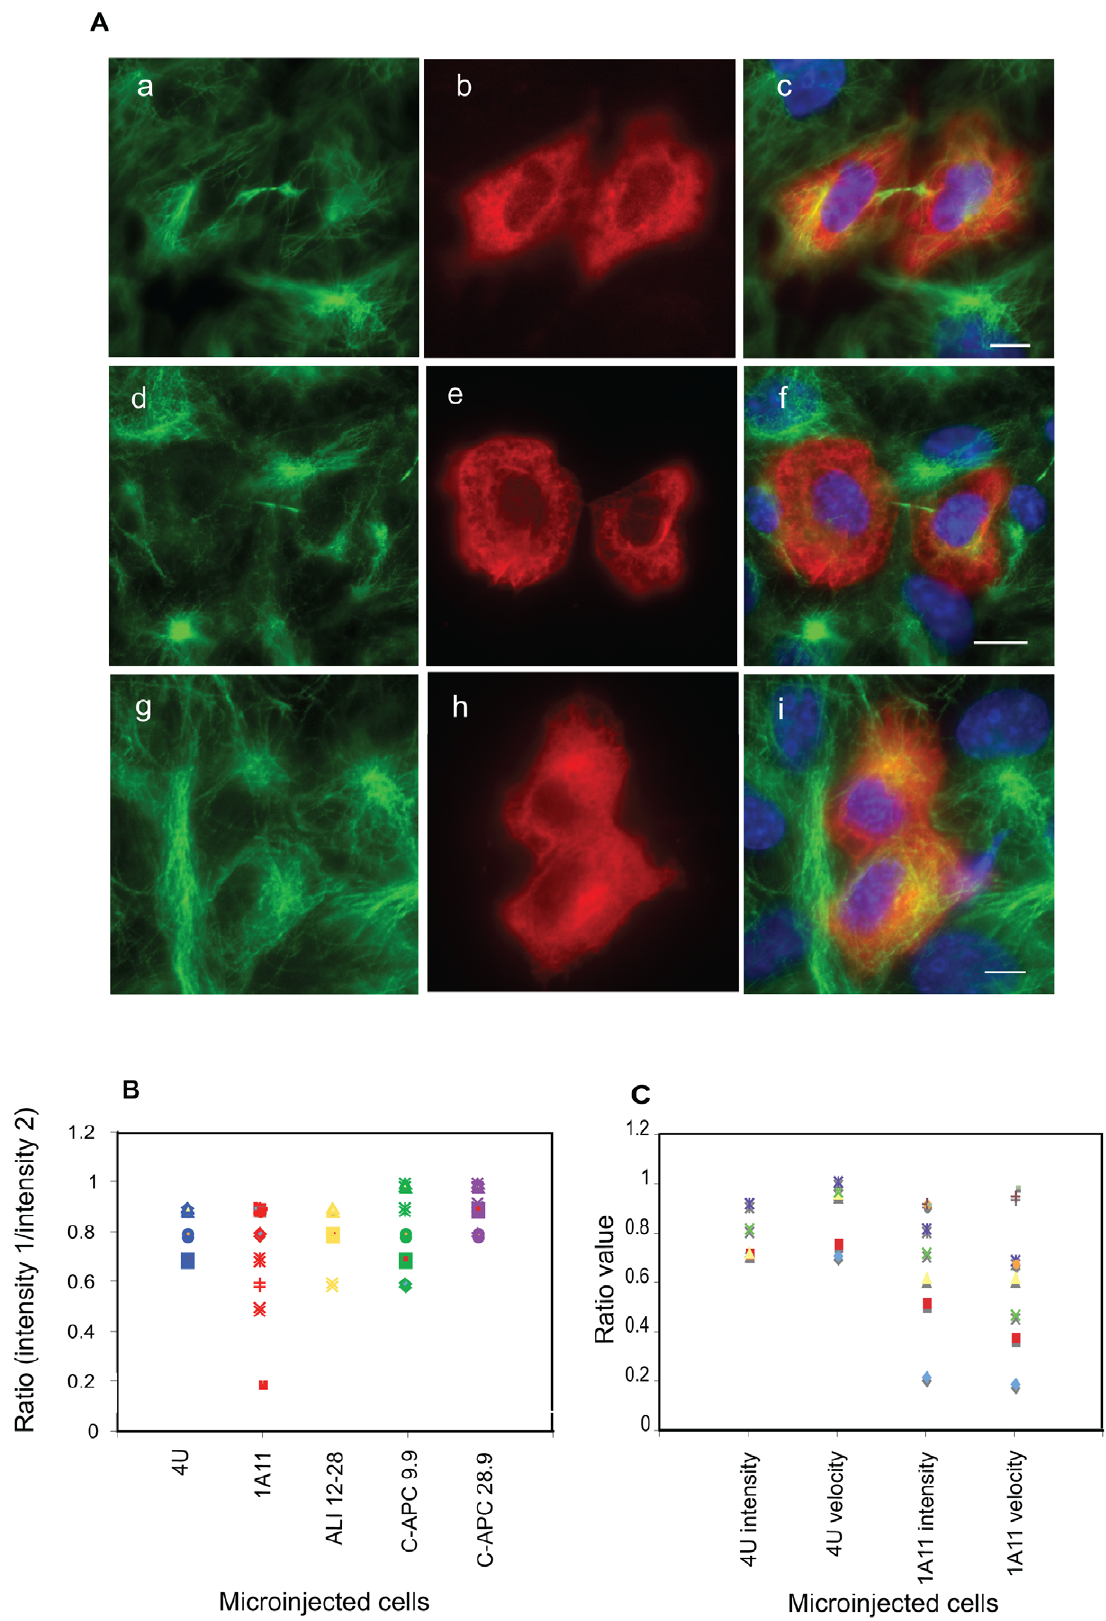
Figure 8. Asymmetrical microtubule content in daughters of cells injected with 1A11. Microinjected cells were allowed to complete mitosis then were fixed and immunostained to reveal the MT cytoskeleton. A: Images obtained from daughter cells after microinjection of mothers with 4 U and 1A11. Daughters of cells injected with the control antibody 4 U were equally sized and displayed an equal content of microtubules (a–c), whereas the daughters of 1A11 injected cells exhibited more uneven microtubule contents (d–i) and in some cases were of unequal sizes (d–f). Scale bar=5 m M. B. PLoS ONE |